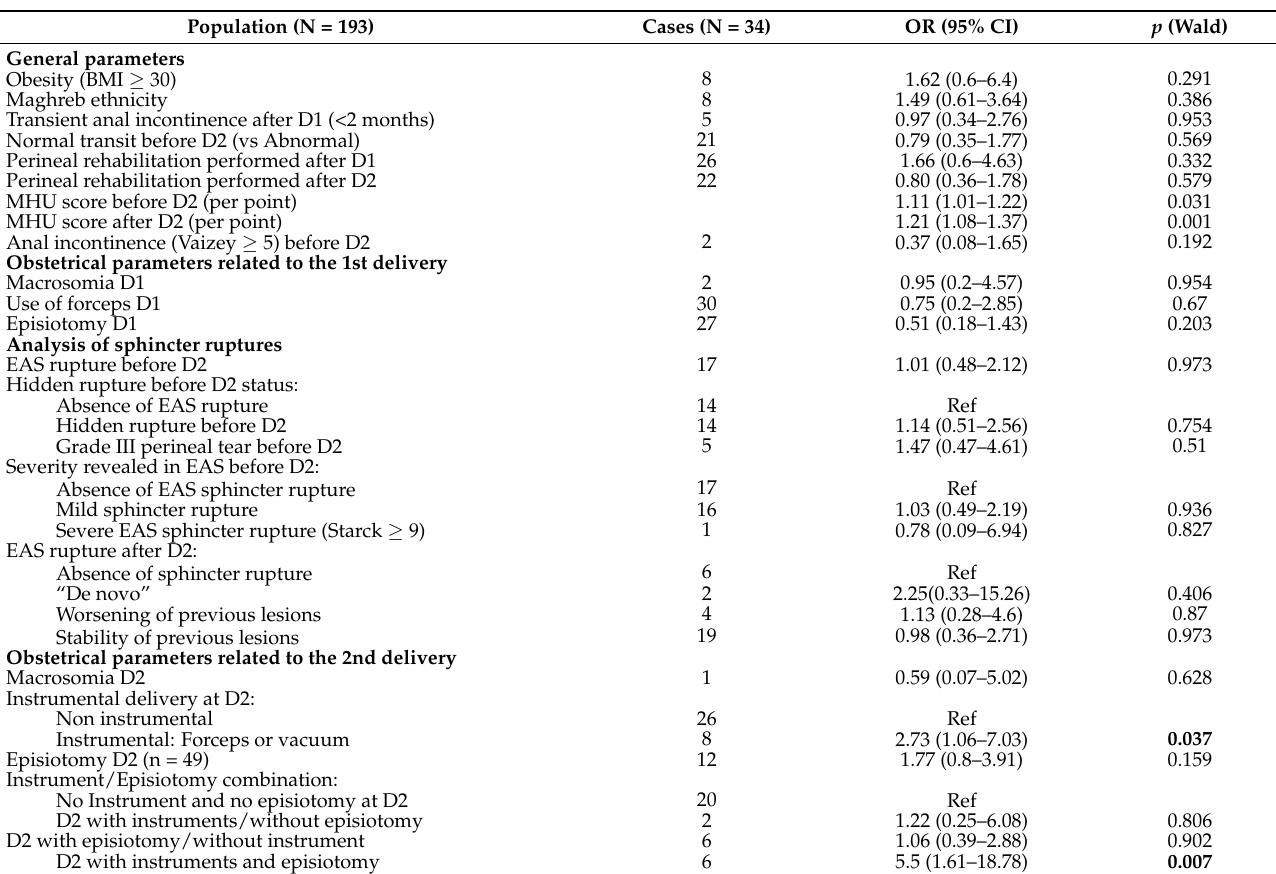
Table 6. Factors associated with a worsening of the Vaizey score ≥ 2 points after second delivery in subgroup of women delivering vaginally (Univariate analysis).